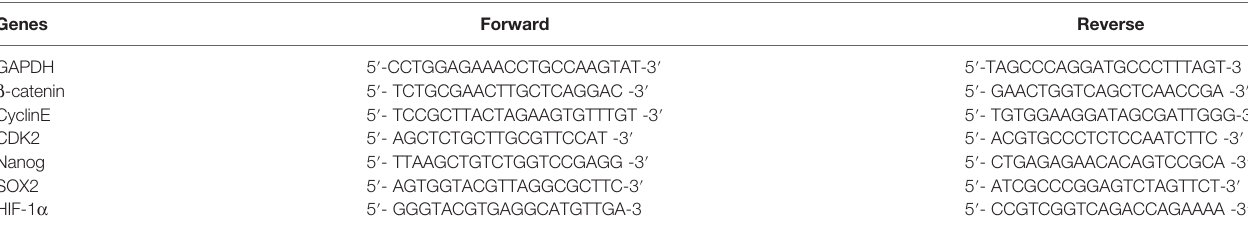
TABLE 1 | Sequences of primers used for gene ampli fi